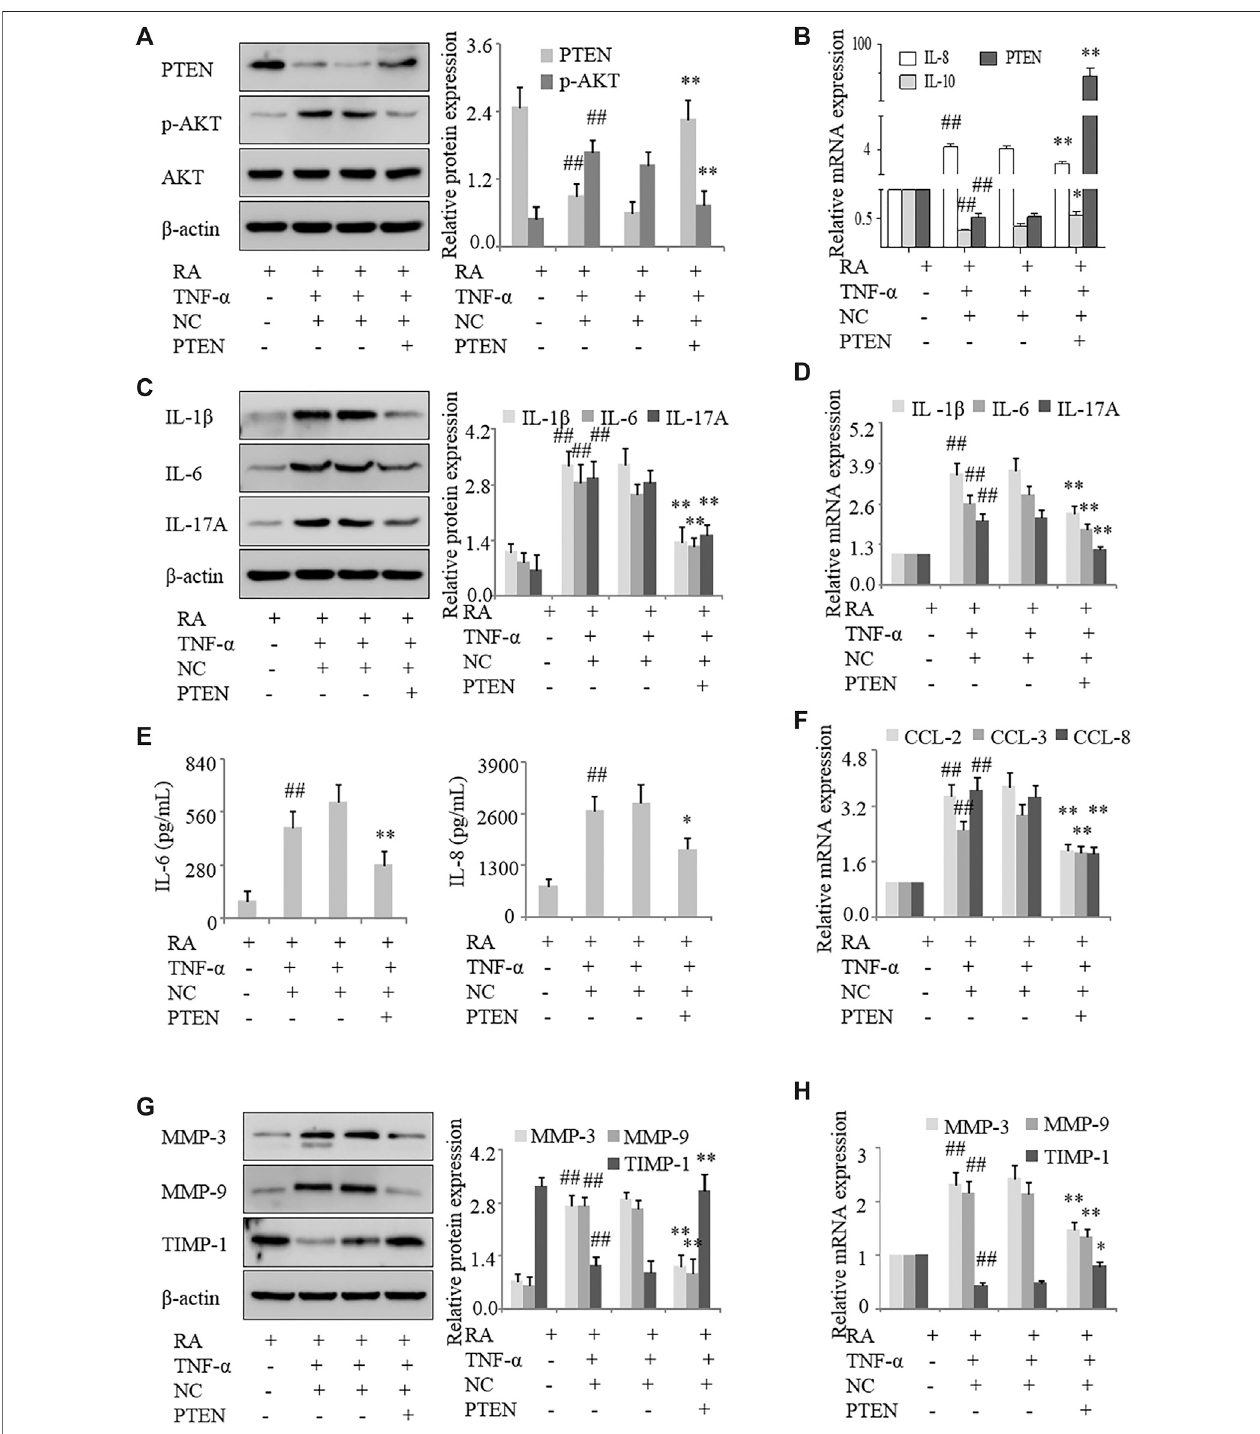
FIGURE 5 | PTEN overexpression inhibits in fl ammation and FLS activation in RA. FLS from the synovium of RA patients overexpressing PTEN were treated with TNF- α (10 ng/ml). (A) PTENand p -AKTproteinlevelsdetectedbywesternblotting. (B) PTEN , IL-10 ,and IL-8 mRNAlevelsdetectedbyqRT-PCR. (C,D) IL-1 β ,IL-6,and IL-17A mRNA and protein levels analyzed by qRT-PCR and western blotting, respectively. (E) IL-6 and IL-8 protein levels in the culture supernatant detected by ELISA. (F) CCL-2 , CCL-3 , and CCL-8 mRNA levels detected by qRT-PCR. (G, H) MMP-3, MMP-9, and TIMP-1 protein levels detected by western blotting. Values represent mean ± SD. ## p < 0.01 vs. RA group; * p < 0.05, ** p < 0.01 vs. pcDNA3.1 group.